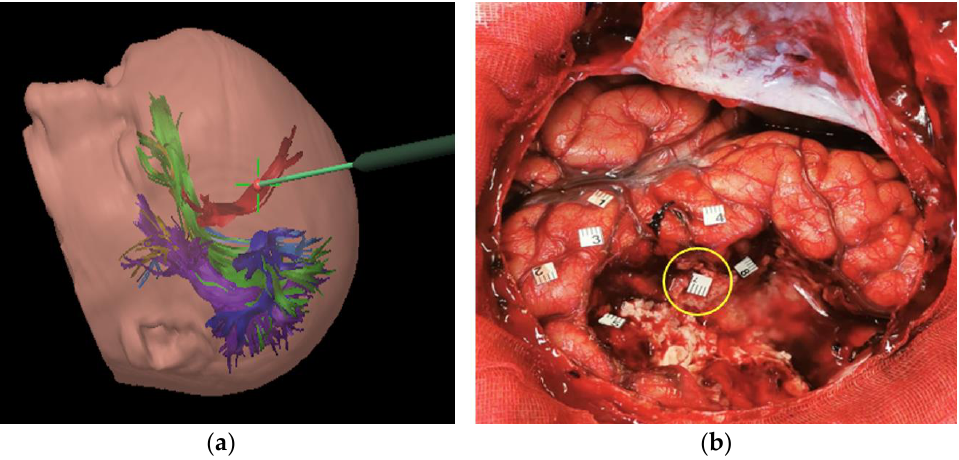
Figure 3. ( a ) Intraoperative 3D image showing the pointer of neuronavigation system positioned at the level of the surgical cavity that encounters the FAT (red fascicle); ( b ) Intra-operative picture of the surgical cavity during resection of left frontal low-grade glioma indicating the stimulated point (n. 7) at the middle part of FAT causing speech arrest.